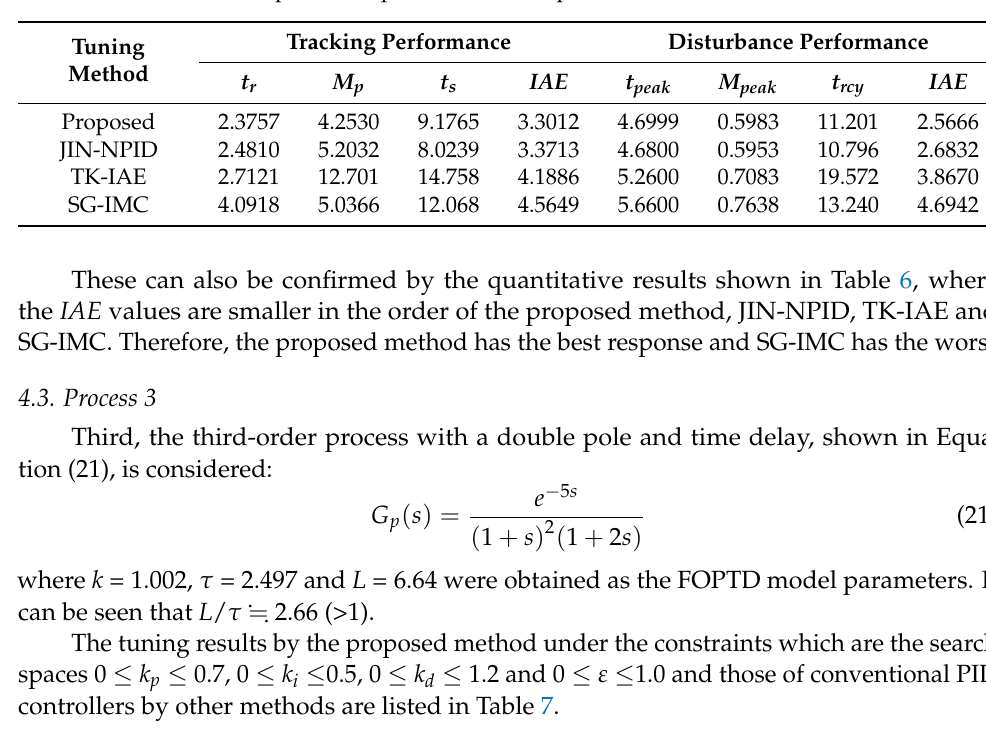
Table 6. Quantitative comparison of performances for process 2 under 10% mismatch.